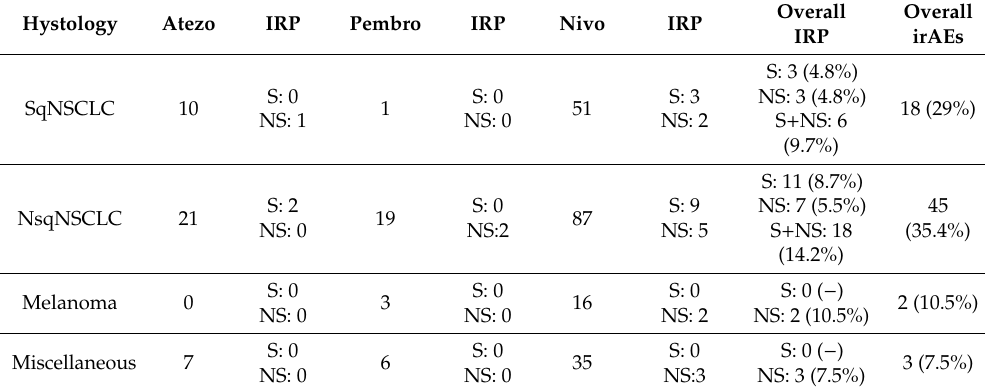
Table 2. Immune-related pneumonitis (IRP) and immuno-related adverse events